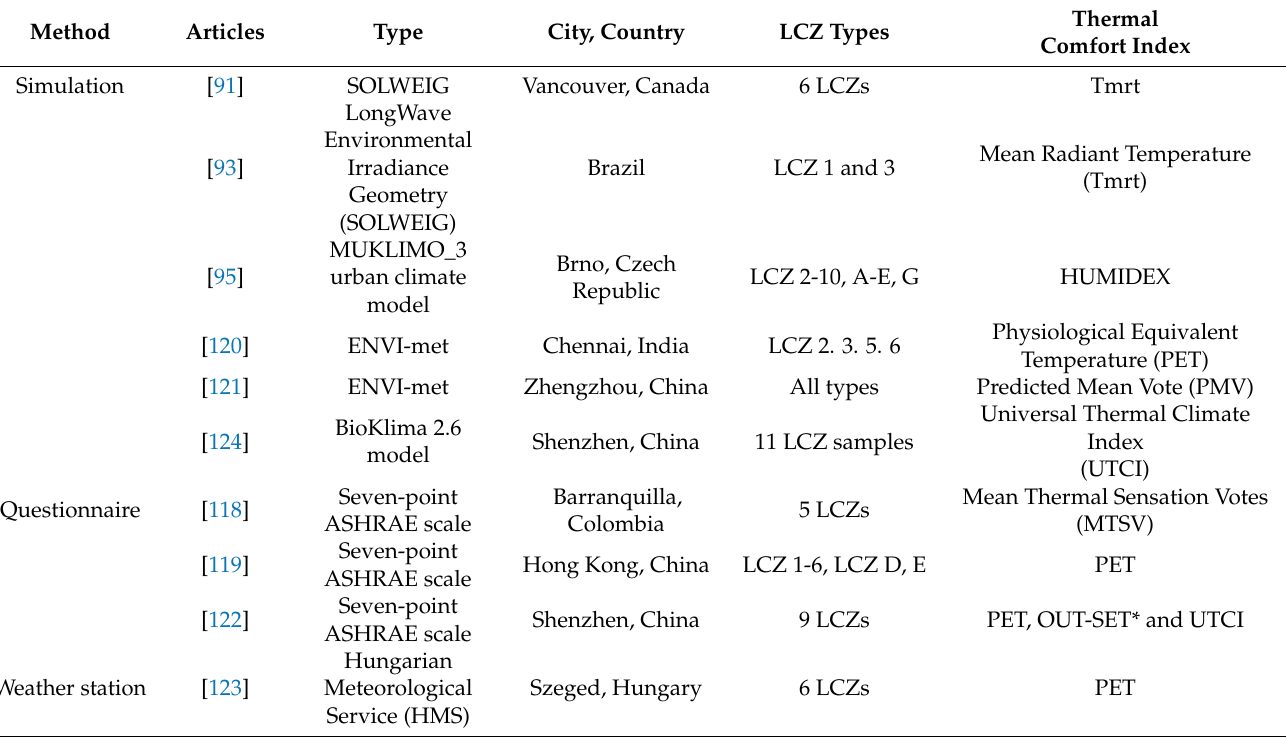
Table 7. Research on LCZ and thermal